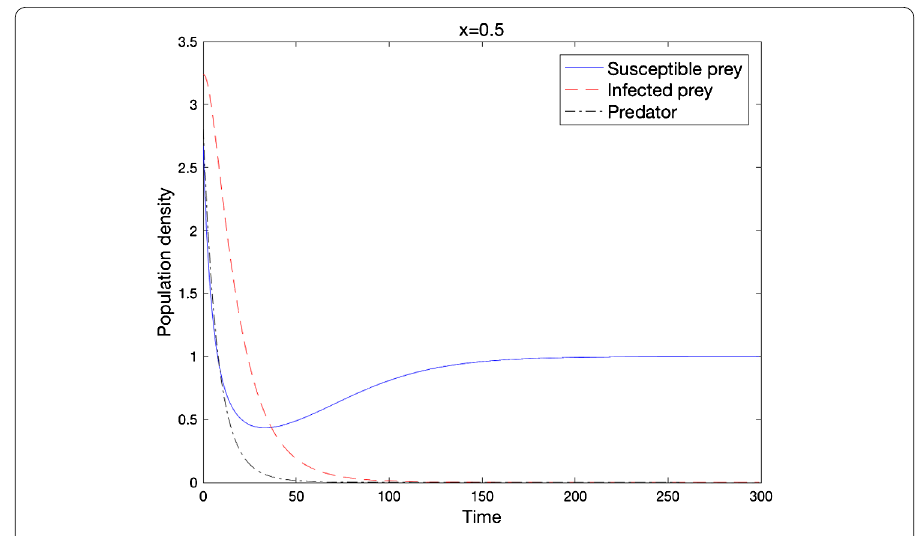
Figure 2 Local stability of e 1 when the condition of Theorem 2.6 holds ( d = 0.01, D = 0.01, r = 0.5, b = 0.430, d 1 = 1.0, d 2 = 2.0, K = 1.0, α = 1.2, β = α , c = 1.0, m =